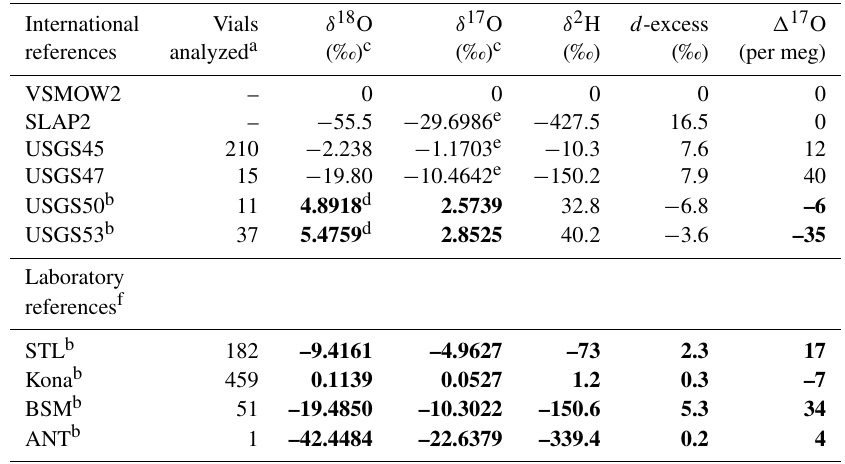
Table 1. Reference materials used in this study. Values in bold are based on measurements by this study.